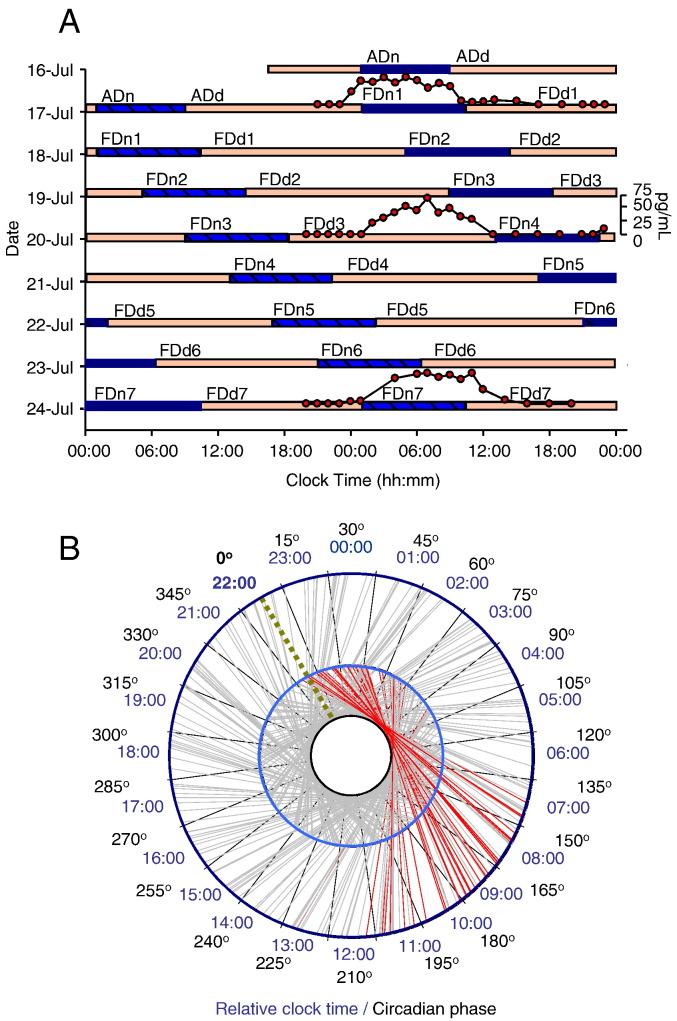
The forced desynchrony protocol.A. Double raster plot of the 28-h forced desynchrony protocol with a representative example of sleep timing and melatonin profile (BB0102, male, 23 years, in vivo circadian period: 24.24 h). Consecutive 24-h periods are plotted next to and below each other. After an 8-hour adaptation night (ADn) followed by an adaption day (ADd) participants were scheduled to a 28-h sleep–wake cycle, in which 9 h and 20 min were scheduled for sleep (blue bars) and 18 h and 40 min for wakefulness (yellow bars). Thus, sleep and wake timing were shifted by 4 h every ‘day’ while at the same time the ratio of sleep and wakefulness remained 1:2, just as during a normal 24-hour day. Melatonin was assessed at baseline (FD1), FD4 and FD7 in order to assess phase and period of the central circadian pacemaker. Blood samples for melatonin concentration assessment were scheduled to be taken hourly but occasionally samples could not be collected due to technical or logistical problems.B. The forced desynchrony protocol represented on a 24-h angular plot indicating each individual baseline (FDn1) sleep period (red lines) against the circadian phase and relative clock time, which corresponds to the habitual sleep timing, duration and circadian phases covered by usual sleep studies. Grey lines indicate all sleep periods scheduled across the circadian cycle (N = 231) during the 10-day protocol for the 34 participants. Each sleep period indicates the time course between the scheduled bedtime (internal light blue circle) and wake-up time (external dark blue circle). The dotted green line indicates the average clock time at circadian phase zero, corresponding to the timing of the dim light melatonin onset.